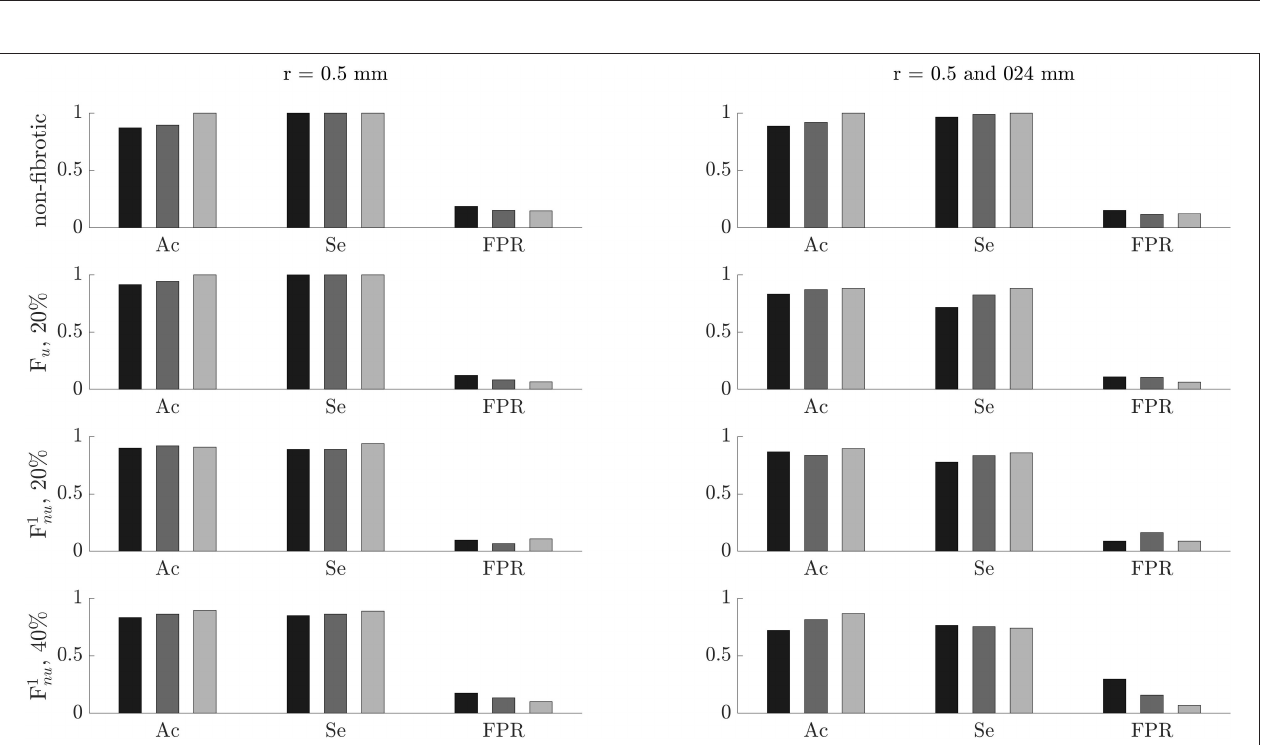
FIGURE 11 | Accuracy (Ac), sensitivity (Se), and false positive rate (FPR) for different electrode-to-tissue distances. The color code from dark to light gray is representative of 2, 1, and 0.5 mm distances.